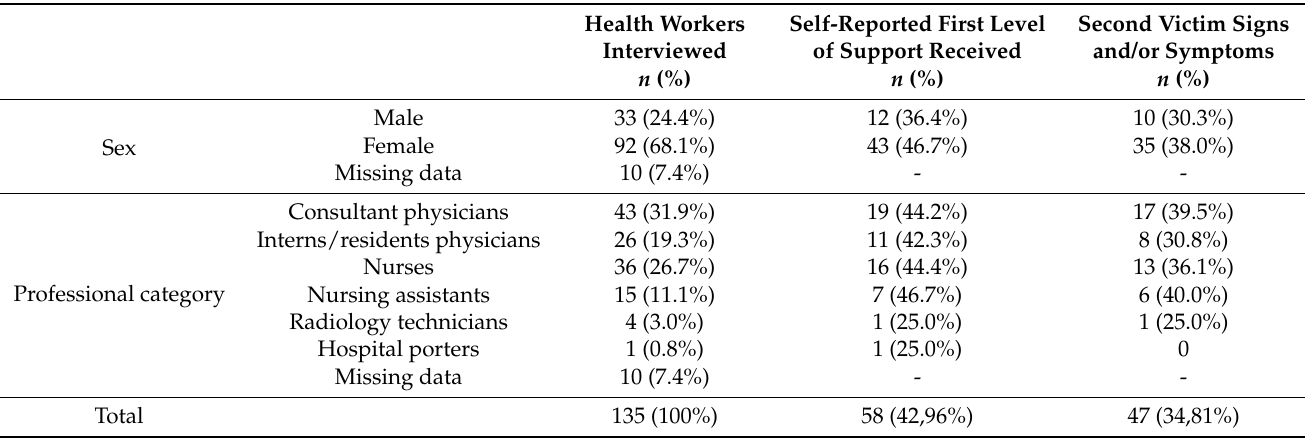
Table 3. Distribution of healthcare workers identified by the program to present second victim signs or symptoms according to the level of support needed for their recovery. First Level Total